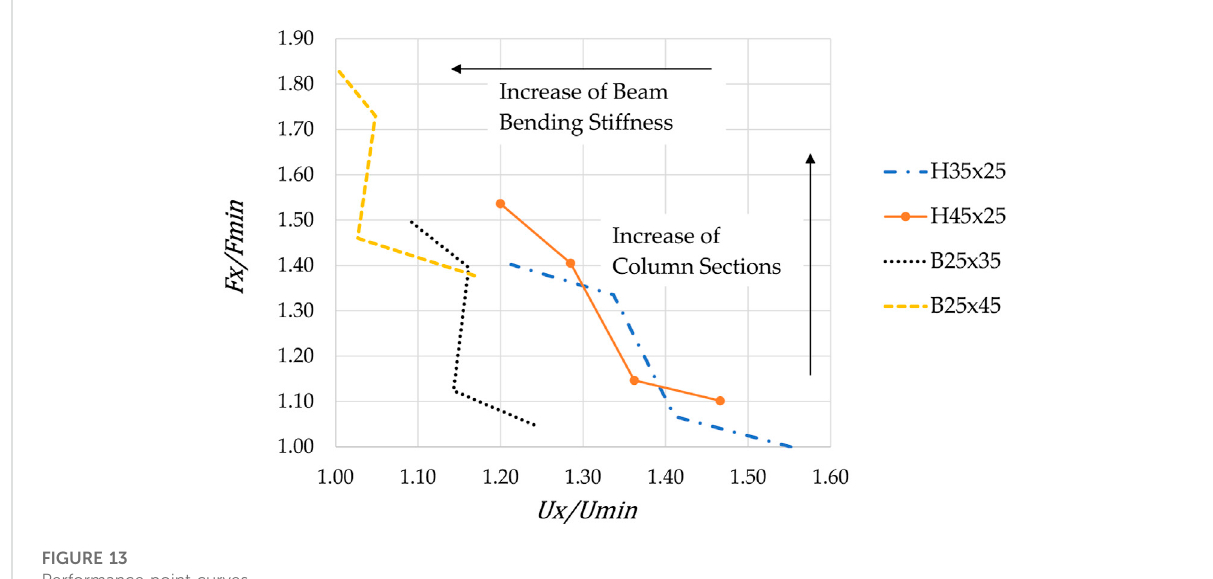
FIGURE 13 Performance point curves.